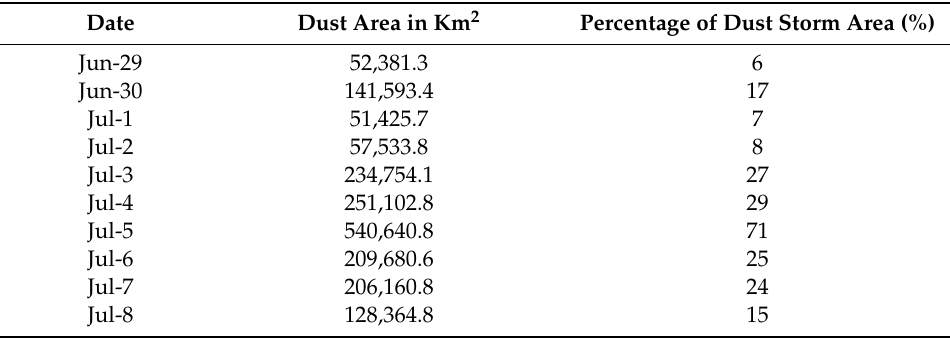
Figure 2. ( a )TB images of Aqua MODIS band 31 (10.78–11.28 µ m) for 10 days (June 29–July 8, 2009) over Iraq and surroundings; ( b ) Aqua MODIS true-color images bands (1, 4 and 3) respectively for 10 days (June 29 to July 8, 2009). Table 1. Dust Storm Areas for June-29–July-8